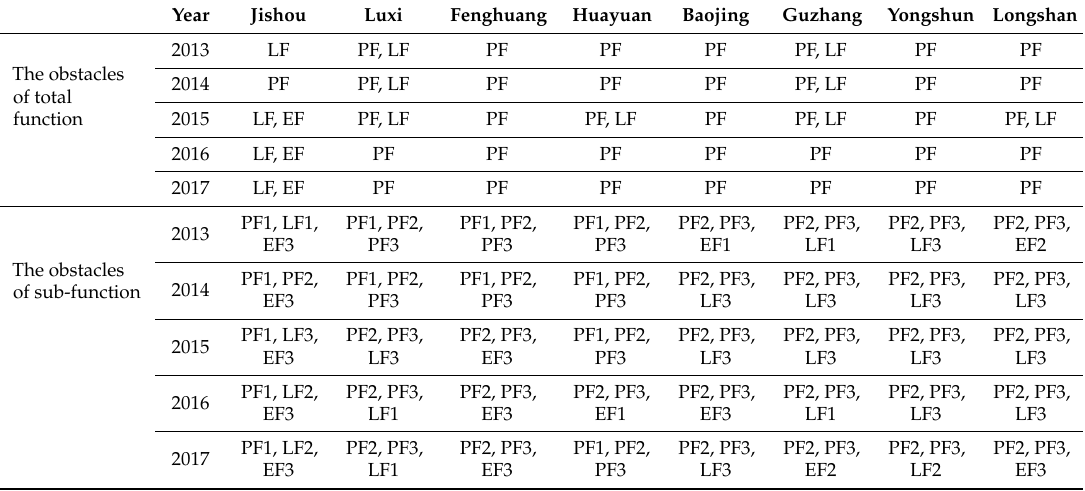
Table 3. The main obstacles of land use function in